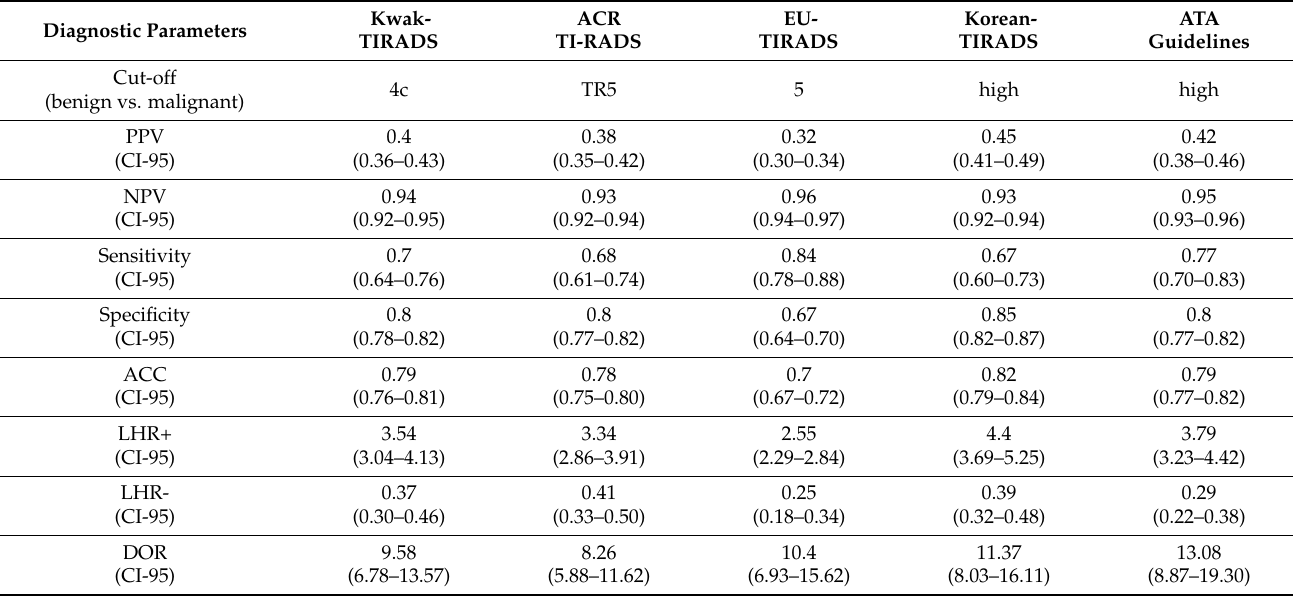
Table 4. Diagnostic performance parameters of the ultrasound risk stratification system (RSSs) for the differentiation between benign and malignant thyroid nodules (TNs).